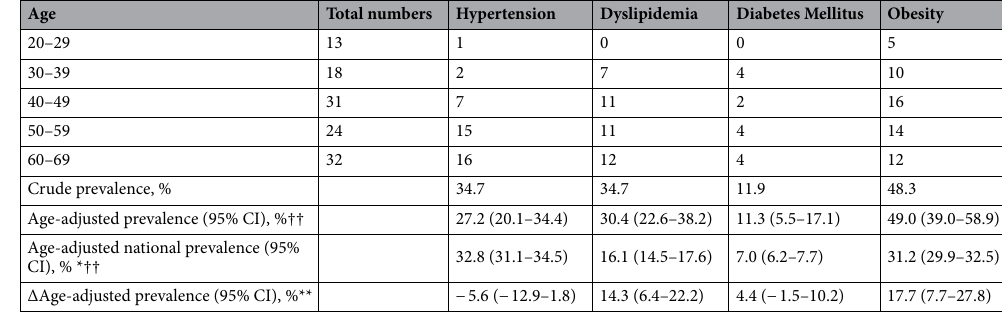
Table 3. Age adjusted prevalence of non-communicable diseases and obesity among the workers in their 20–60 (n = 118).† Confidence interval (CI). † Four workers were excluded because the data of the National Health and Nutrition Examination Survey only included persons ≥ 20 years old. Only one worker, over the age of 70 years, was excluded from the analysis. †† Age adjustment was performed using the 1985 model in Japan. *Based on the data from the National Health and Nutrition Examination Survey. **Difference in age-adjusted prevalence between this study and National Health and Nutrition Examination